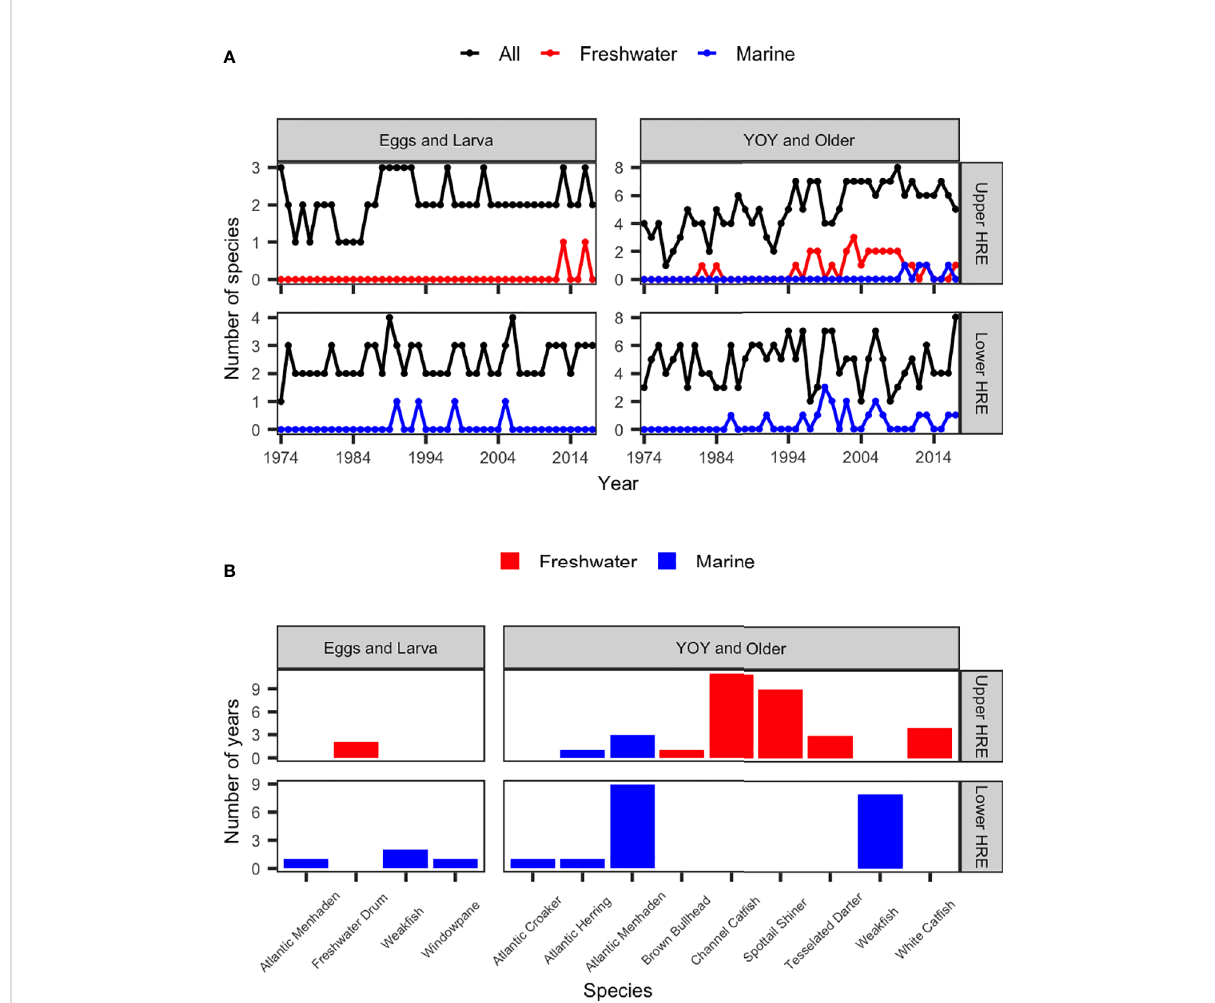
FIGURE 8 (A) Number of dominant species for early (eggs and larva) and older (young-of-year [YOY] and older) life stages of all, marine, and freshwater species; and (B) number of years observed for dominant marine and freshwater species, during May-July from 1974 to 2017 in the upper and lower Hudson River Estuary